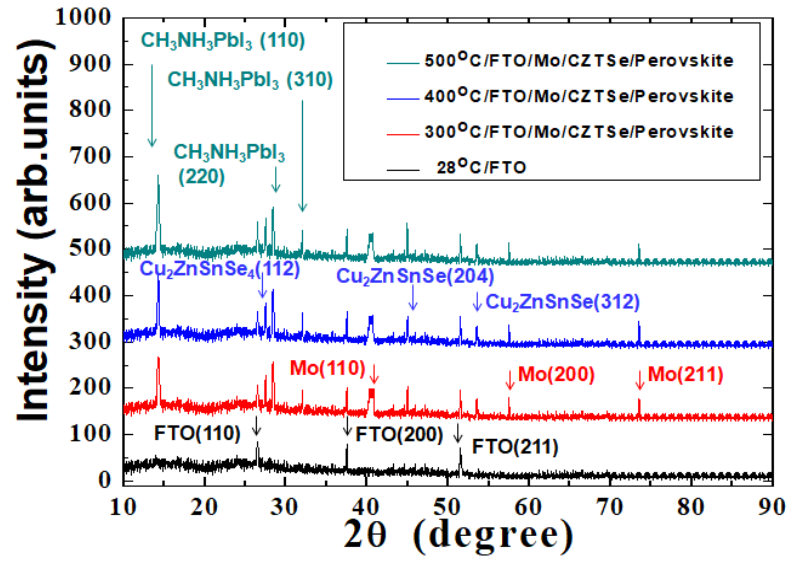
Figure 3. XRD spectra of MAPbI 3 /CZTSe/Mo/FTO multilayered thin-film structures after thermal annealing at various temperatures.